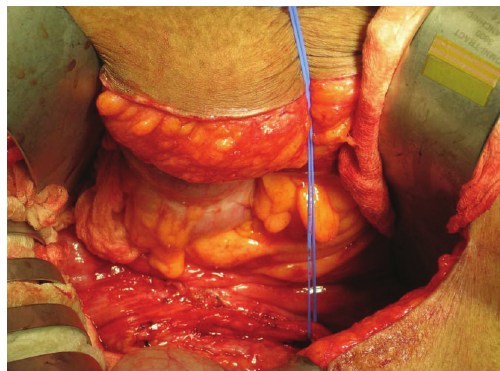
Figure 3: Intraoperative photograph of the right ureter isolated and freed from the surrounding fibrosis.